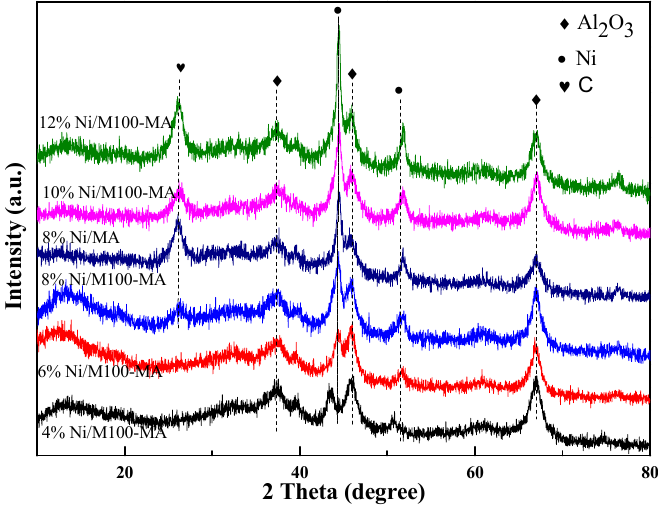
Figure 8. XRD patterns of the spent catalysts.